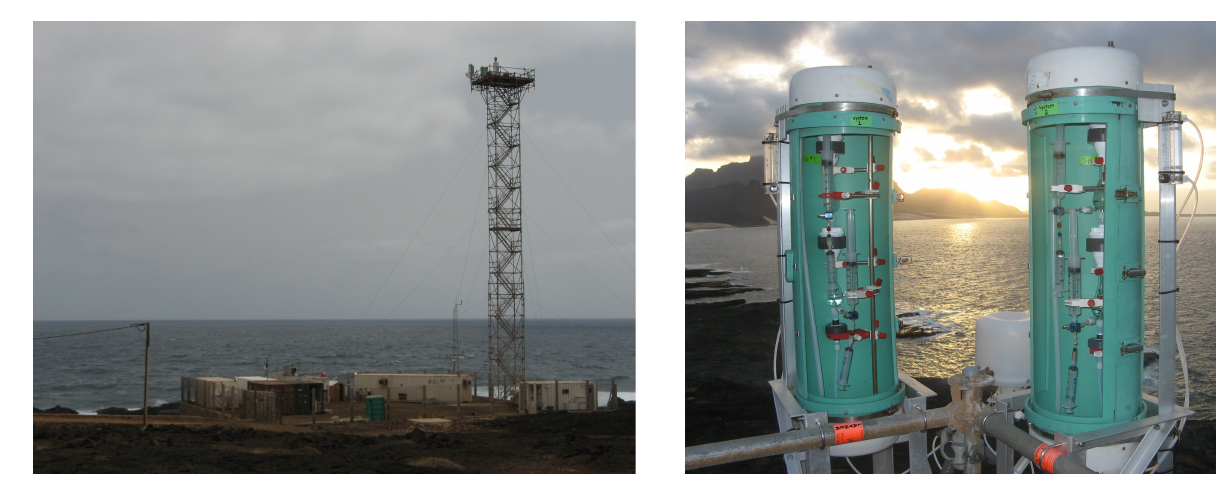
Figure 1. The sampling tower at the Cape Verde Atmospheric Ob- servatory in 2007.